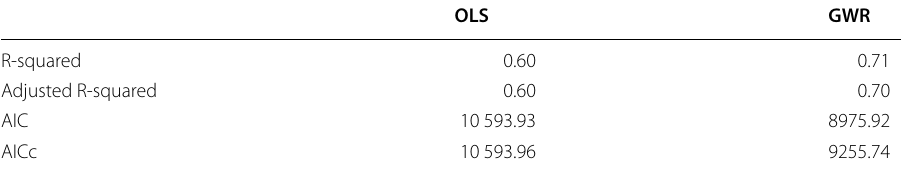
Table 3 Goodness-of-fit model